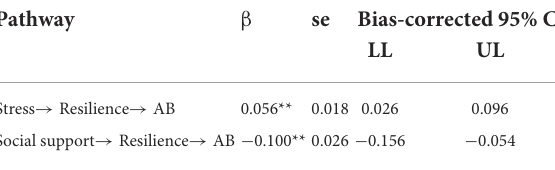
TABLE 9 Indirect effect of the model. Pathway β se Bias-corrected 95% CI Stress → Resilience →